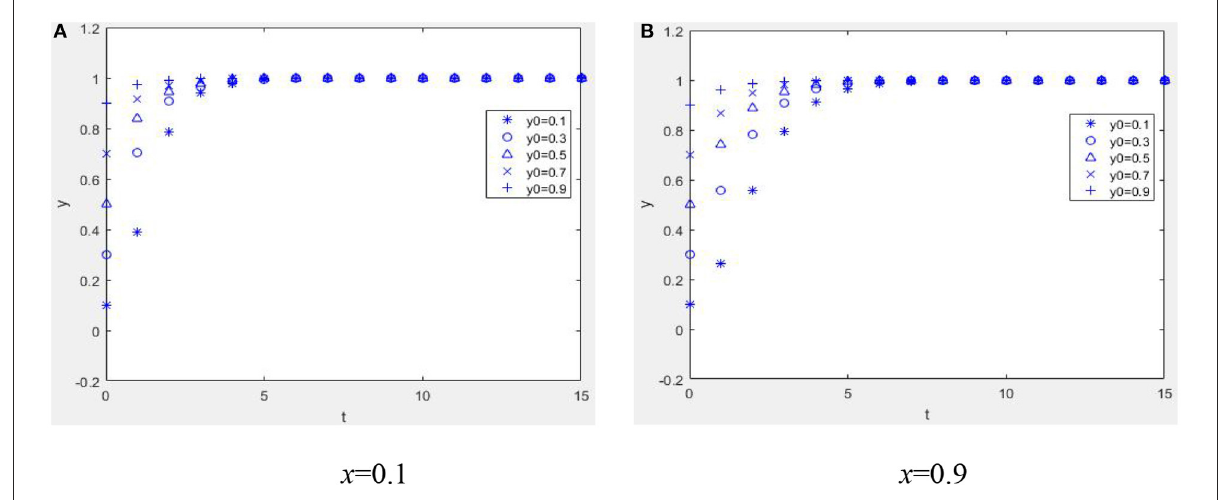
FIGURE3 Dynamic evolution diagram under Case 2. (A) x = 0.1 and (B) x = 0.9.